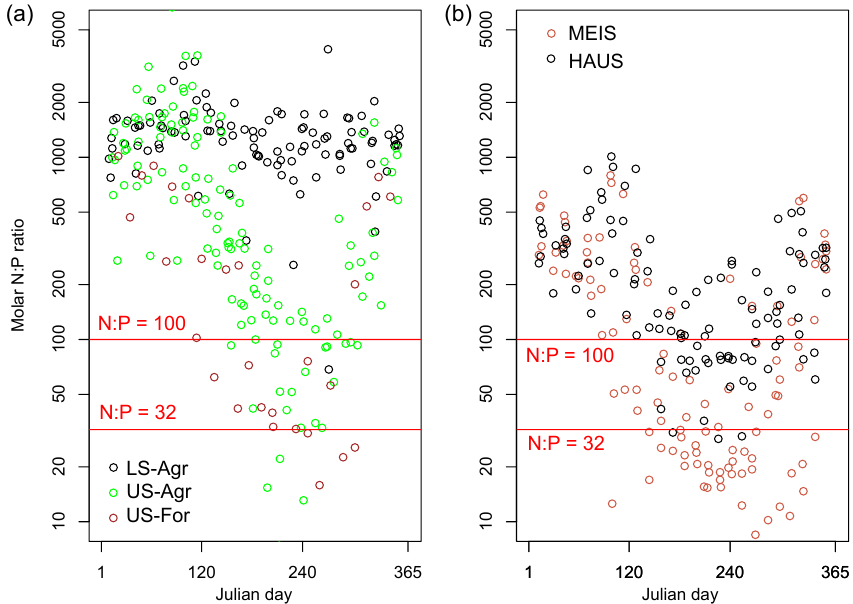
Figure 4. Intra-annual variability of the molar N:P ratio calculated with grab sampling data in headwater catchments (a) and downstream reaches (b) . The two thresholds represent N : P = 32mol : mol and N : P = 100mol : mol.